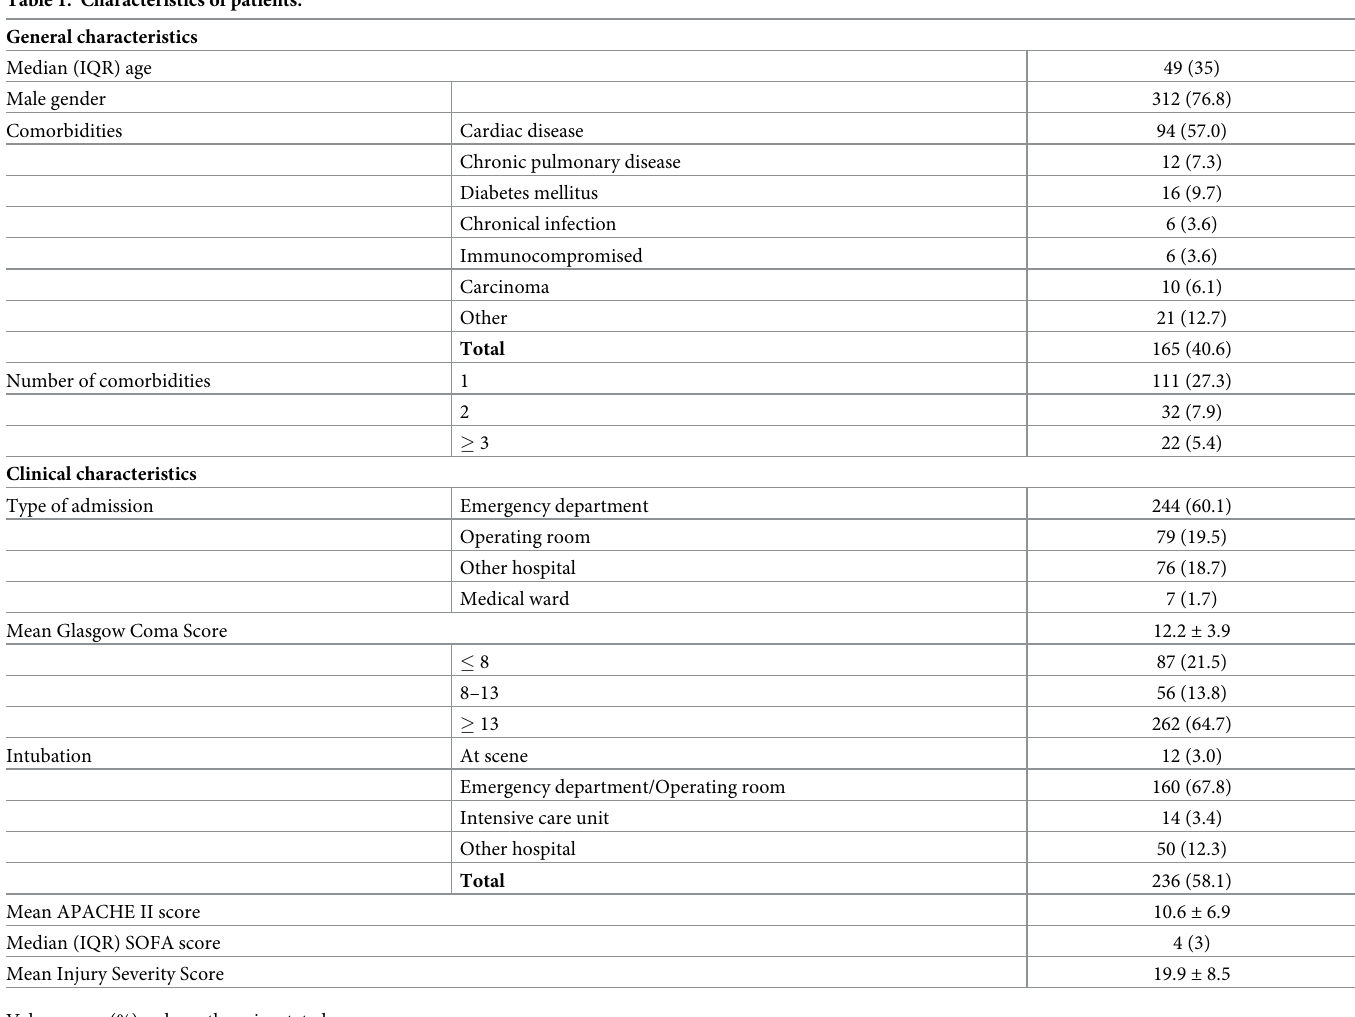
Table 1. Characteristics of